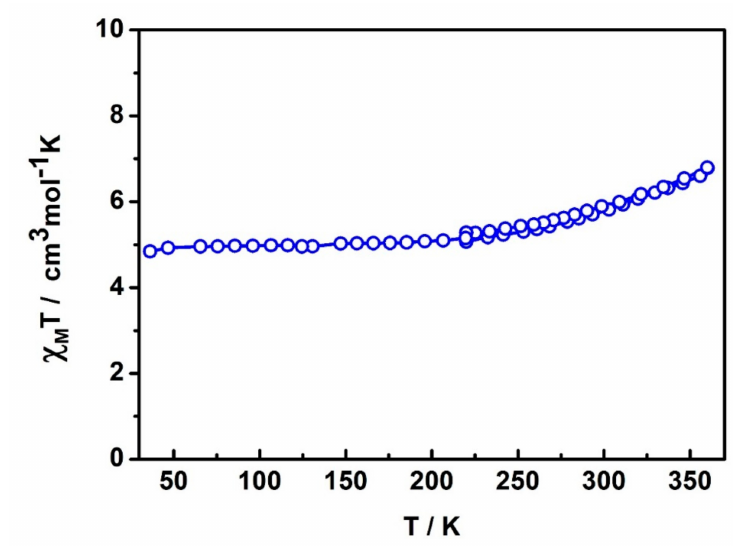
Figure 8. Variable-temperature magnetic susceptibility ( χ M T) measurements for compound 6 with heating and cooling shown in the range 220–360